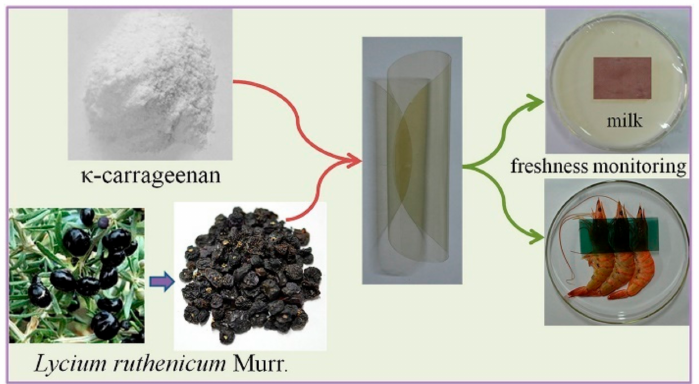
Figure 6. Applications of colorimetric film for milk and shrimp freshness monitoring